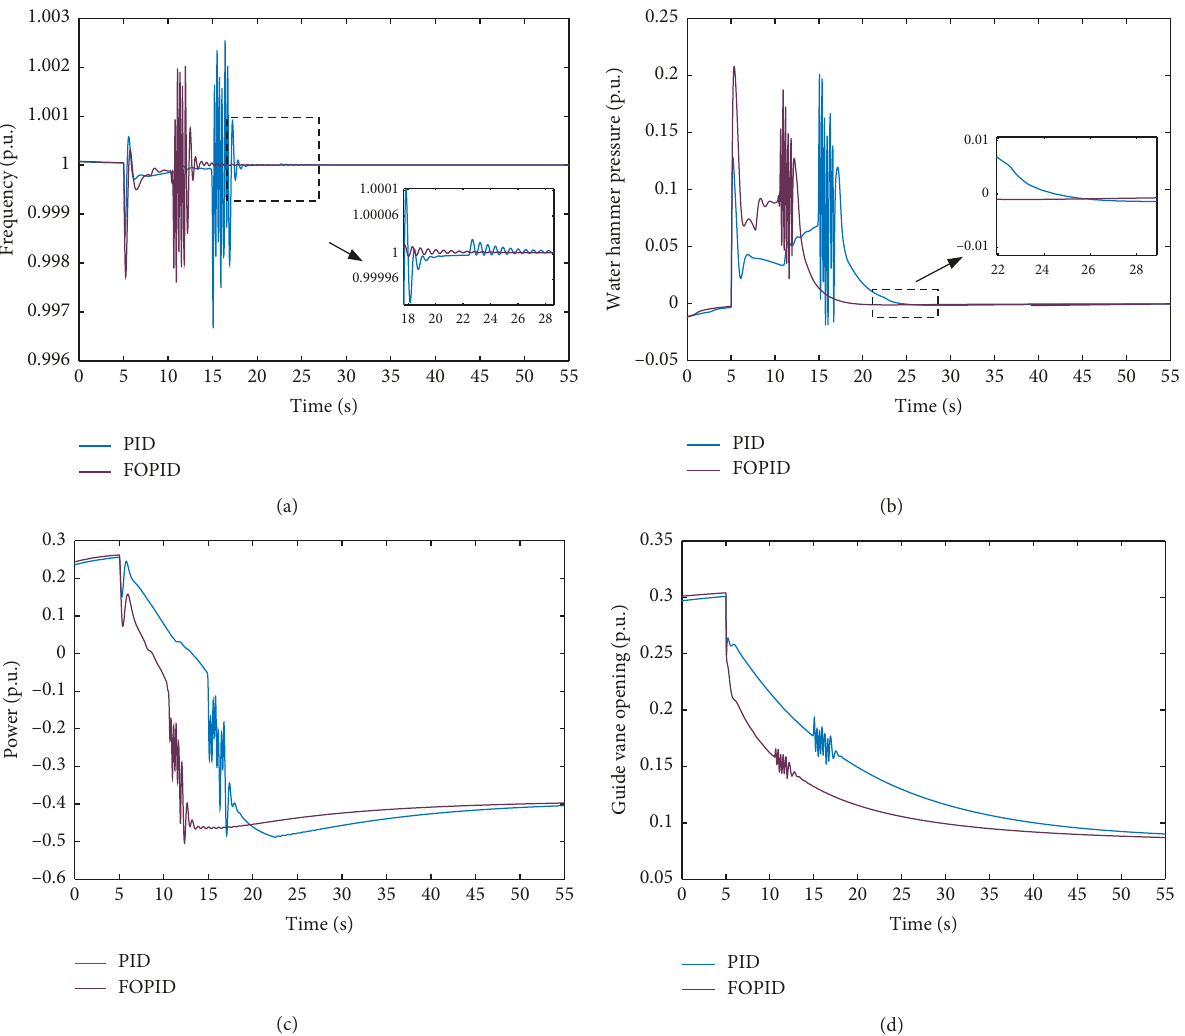
Figure 10: Dynamic response of each output with Δ f � − 0 . 5Hz. (a) Frequency. (b) Water hammer pressure. (c) Power. (d) Guide vane